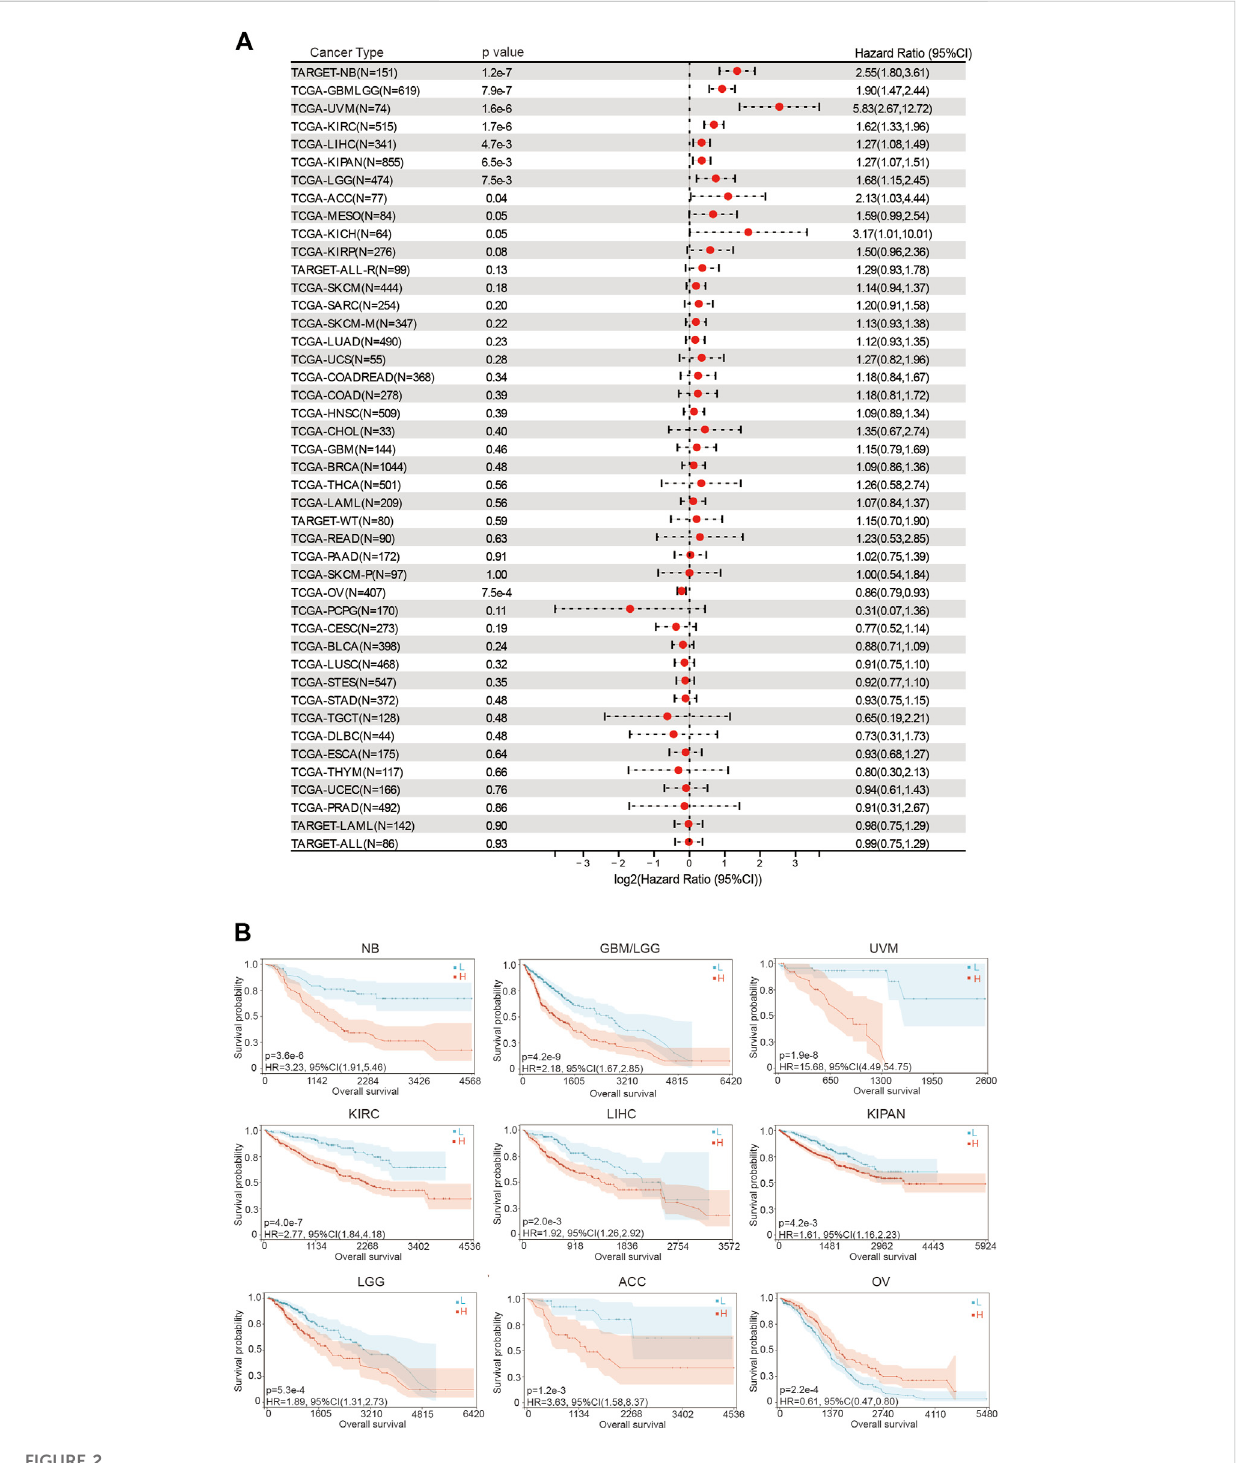
KIPAN (HR = 1.27, 95%CI: 1.07 – 1.51), LGG (HR = 1.68, 95%CI: 1.15 – 2.45), ACC (HR = 2.13, 95%CI: 1.03 – 4.44), and OV (HR = 0.86, 95%CI: 0.79 – 0.93) (Figure 2A). Kaplan – Meier curves were